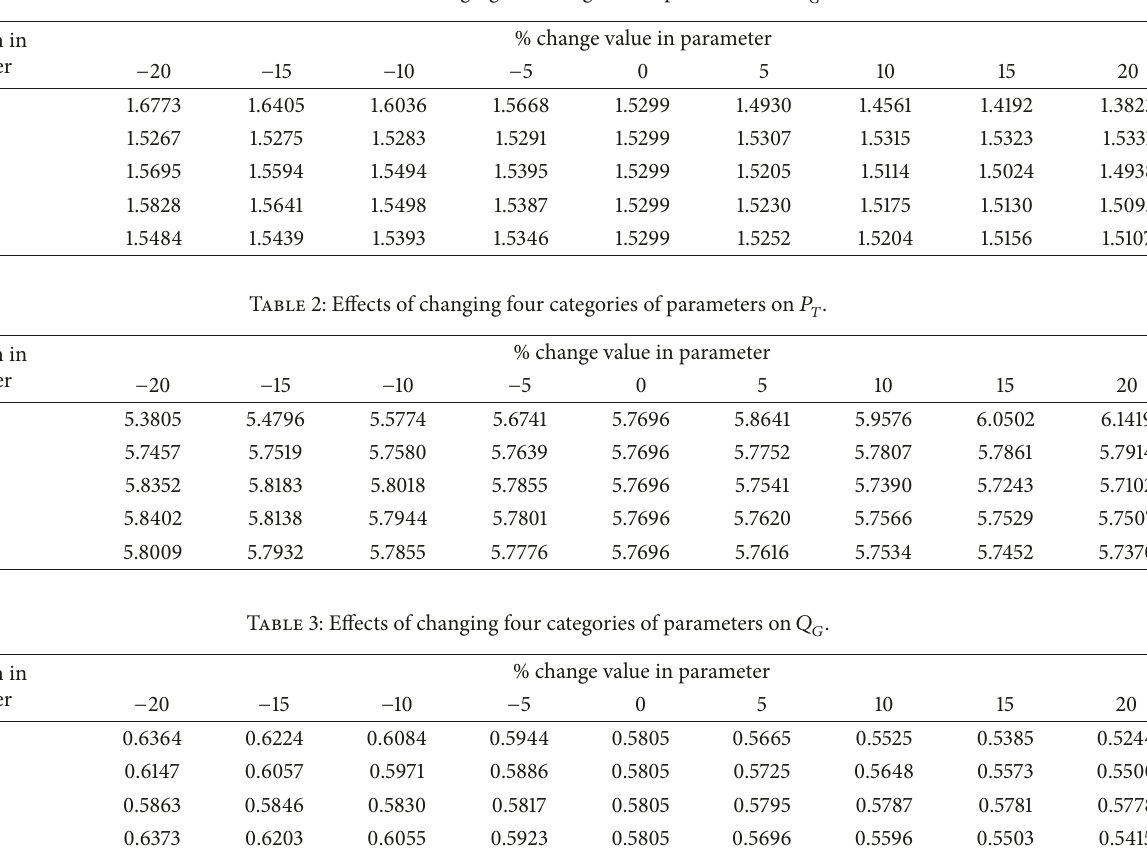
Table 1: Effects of changing four categories of parameters on 𝑃 𝐺 .